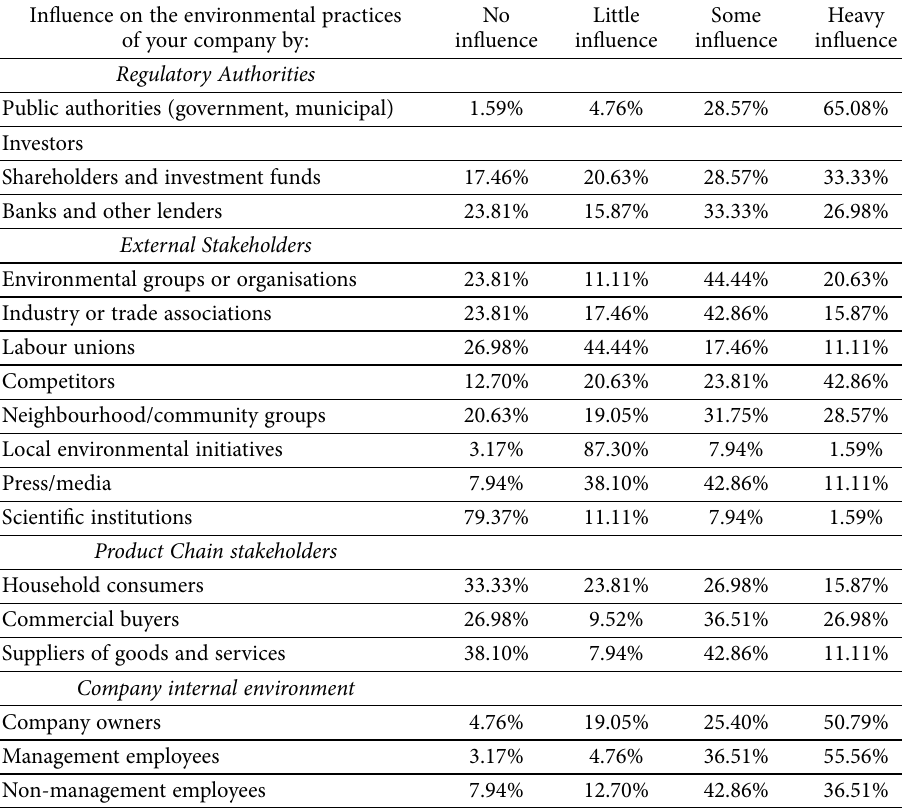
Table 1. Influencing factors on the Environmental Practices of the company Influence on the environmental practices of your company by: